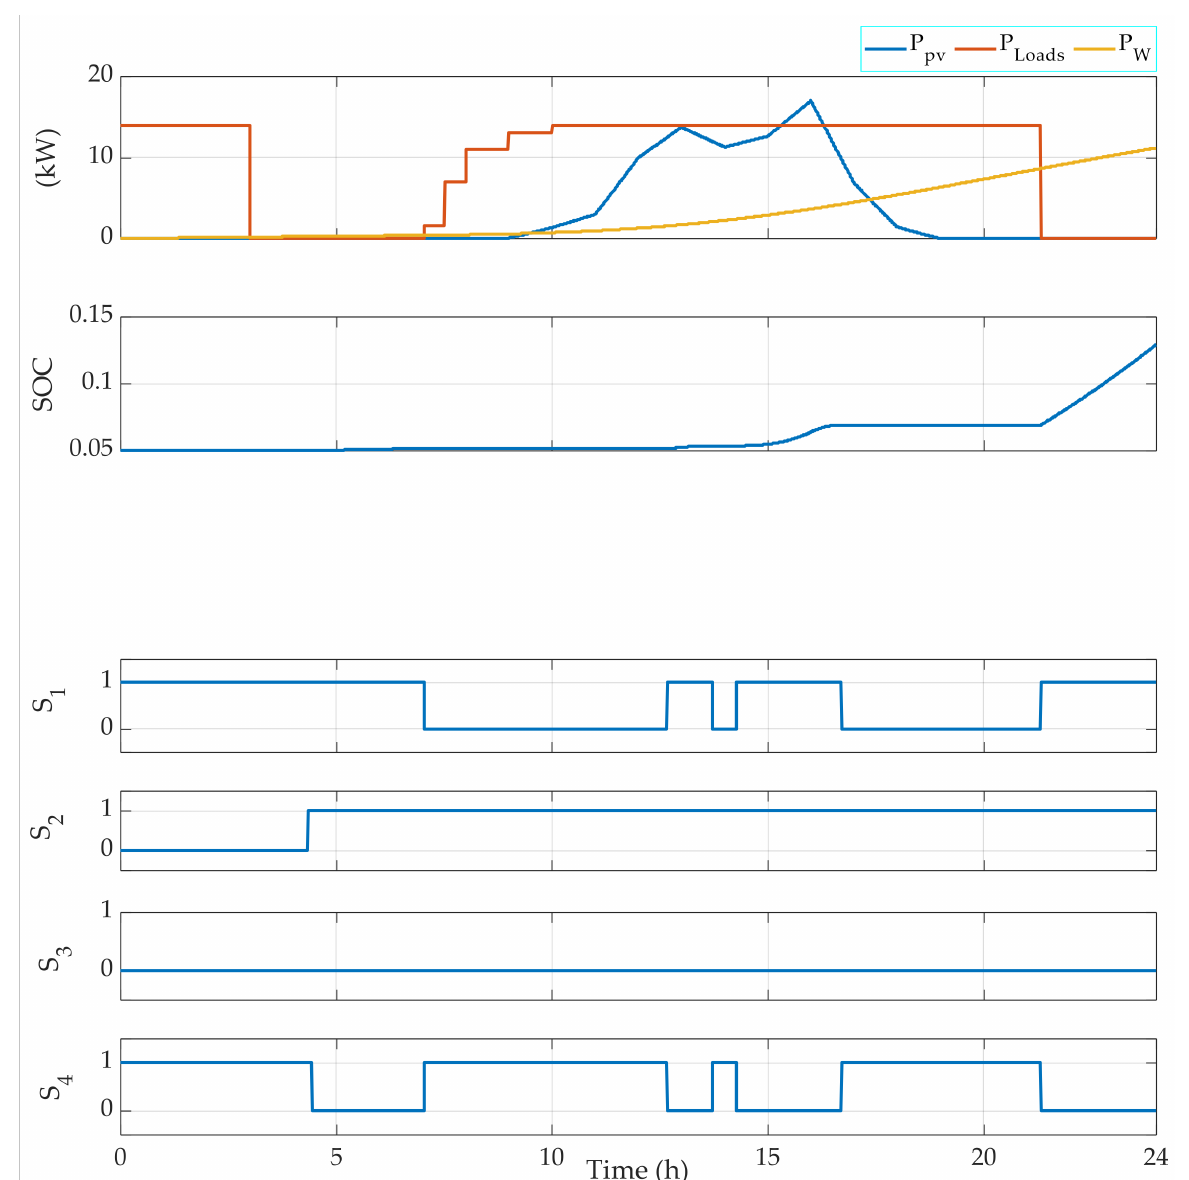
Figure 8. EMS results for the photovoltaic system in December using a variable loads power using an initially fully discharged battery